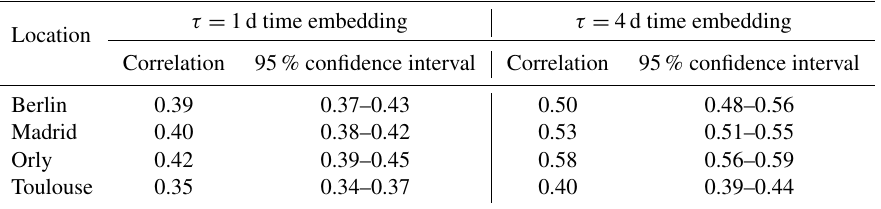
Table 3. Correlation between observations and the median of 100 simulations for the winter (DJF) based on analogs computed with an embedding of 1 and 4d for the geographic domain with the coordinates [30 ◦ W–20 ◦ E; 40–60 ◦ N] for a lead time of 5d.